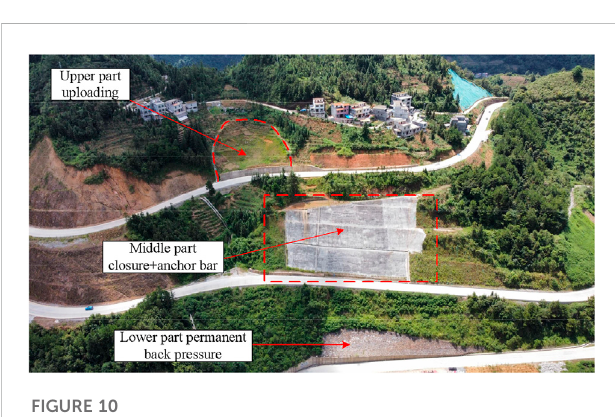
FIGURE 10 Aerial photograph of landslide after treatment (October